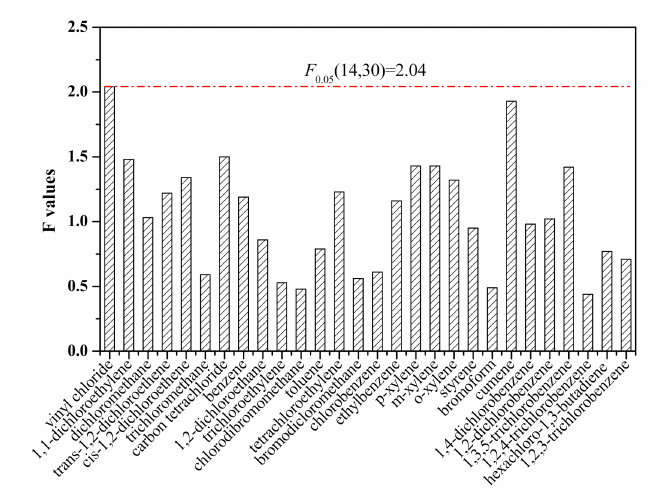
Figure 2. Results of homogeneity study of 28 VOCs in spiking